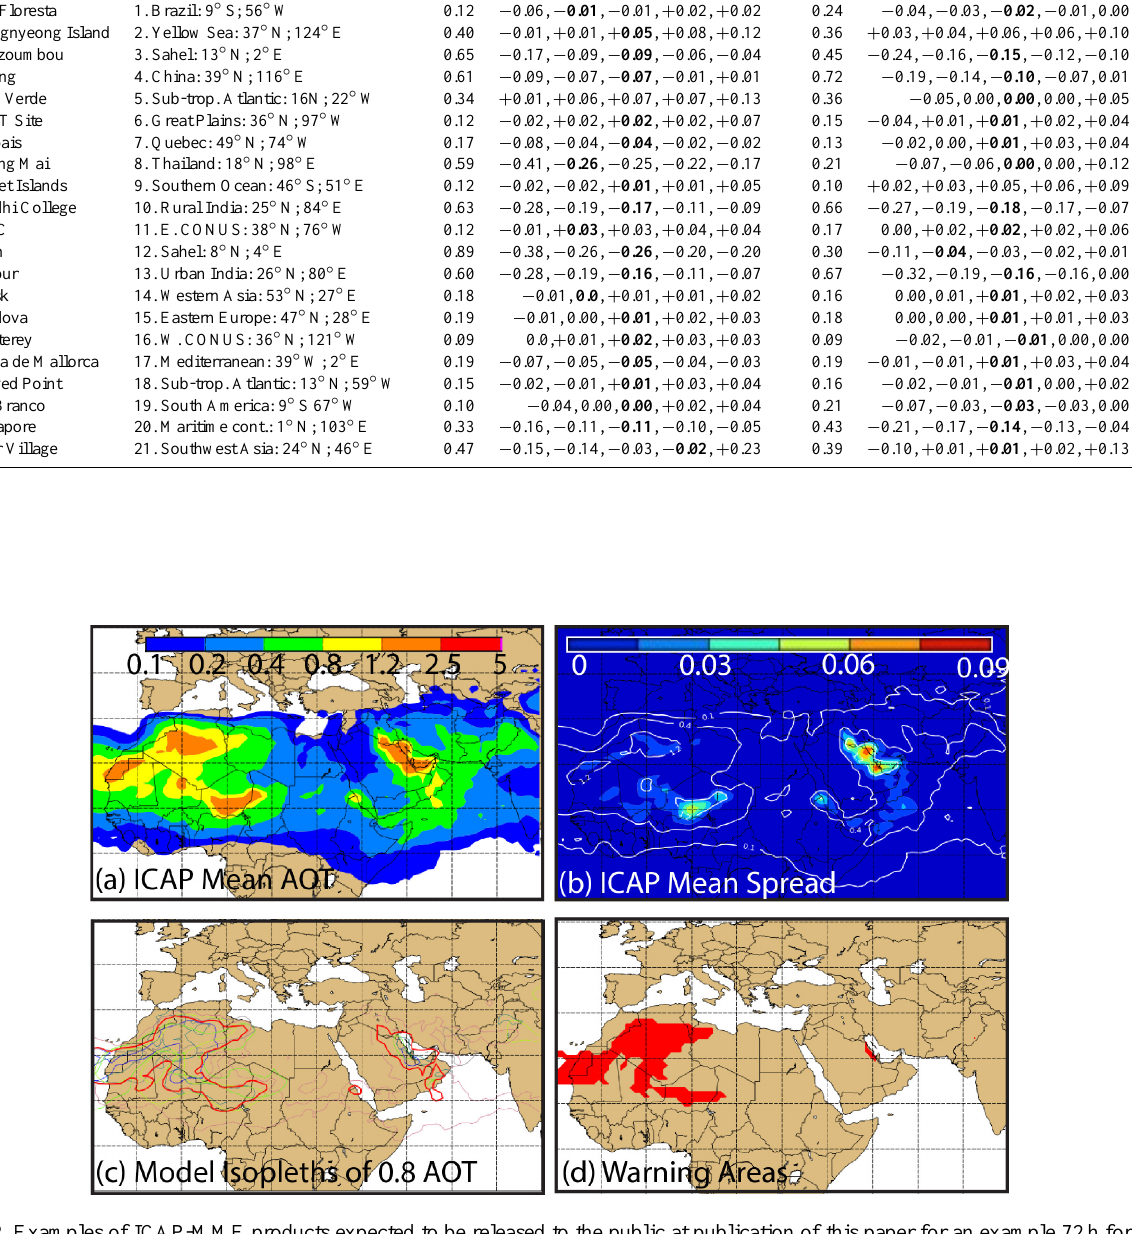
Figure 2. Examples of ICAP-MME products expected to be released to the public at publication of this paper for an example 72h forecast of 2012’s most significant dust events plus a secondary event over the Arabian Gulf using all six dust members. (a) Ensemble mean 550nm AOT; (b) Mean/Spread of the six ensemble members, with the standard deviation as color and AOT isopleths; (c) Spaghetti plot of AOT 0.8 isopleth; (d) Dust warning areas where more than half of the models predict